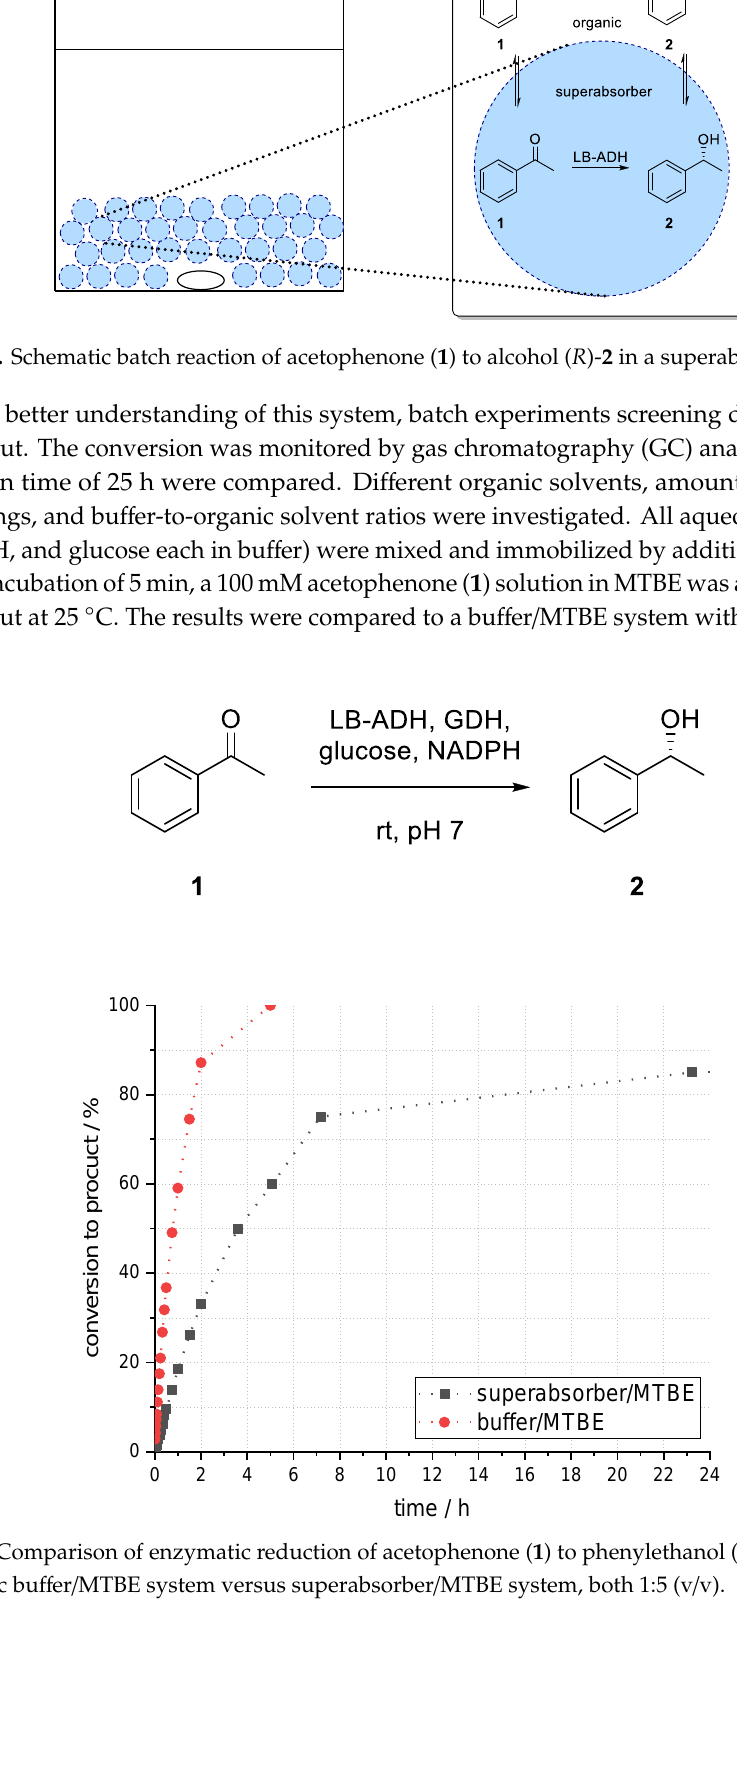
Compared to a reduction using a biphasic buffer/MTBE system, the reaction in the superabsorber/MTBE system was much slower. In the biphasic system, full conversion to alcohol ( R )- 2 could be achieved after 5 h, whereas in the superabsorber system after 5 h only 60% conversion to ( R )- 2 was observed. A maximum conversion to product ( R )- 2 of 85% after 23 h was observed (Figure 5). Thereafter, no further conversion could be observed. 3.2. Studies on the Influence of Organic Solvents on the Reduction of Acetophenone with a Superabsorber- Immobilized Recombinant Alcohol Dehydrogenase from Lactobacillus brevis To investigate the influence of different solvents, the organic phase was changed while other parameters were kept constant. A range of standard solvents with different properties were investigated. As dichloromethane (DCM) is usually not suitable for enzyme catalysis, it would be interesting to learn about the performance of the investigated system towards this solvent in comparison to other organic “standard solvents” . In addition, methyl tert -butyl ether (MTBE) and diethyl carbonate were chosen as greener solvent options. As shown in Figure 6, the highest conversion to product ( R )- 2 after 24 h was obtained for a system using MTBE as an organic solvent component (85%). A maximum conversion to the desired product of 55% for toluene could be observed after 26 h. Thereafter, no further product formation was observed. The result for diethyl carbonate was comparable to that of toluene. With DCM as